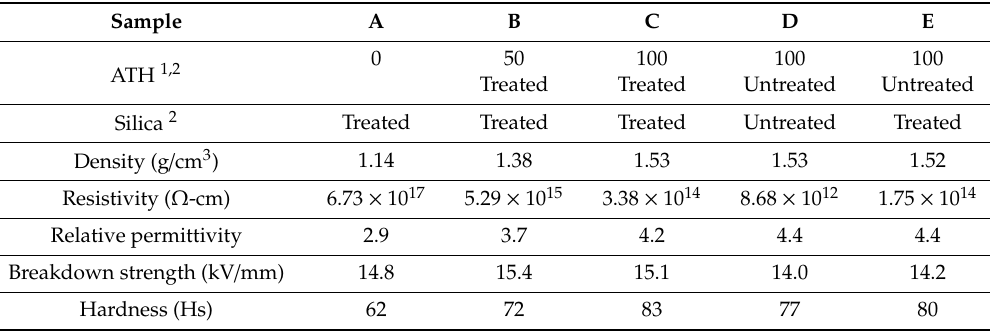
Table 1. Physical properties of